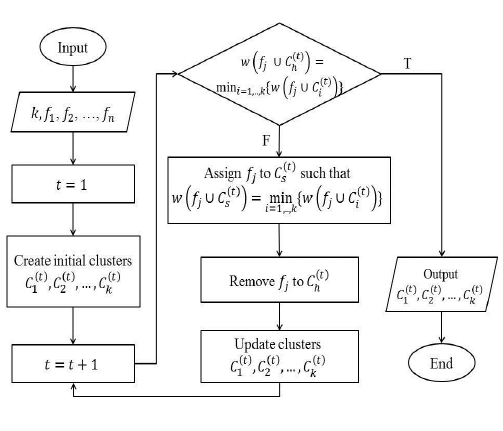
Fig. 1: Flowchart demonstrates process of non- hierarchical